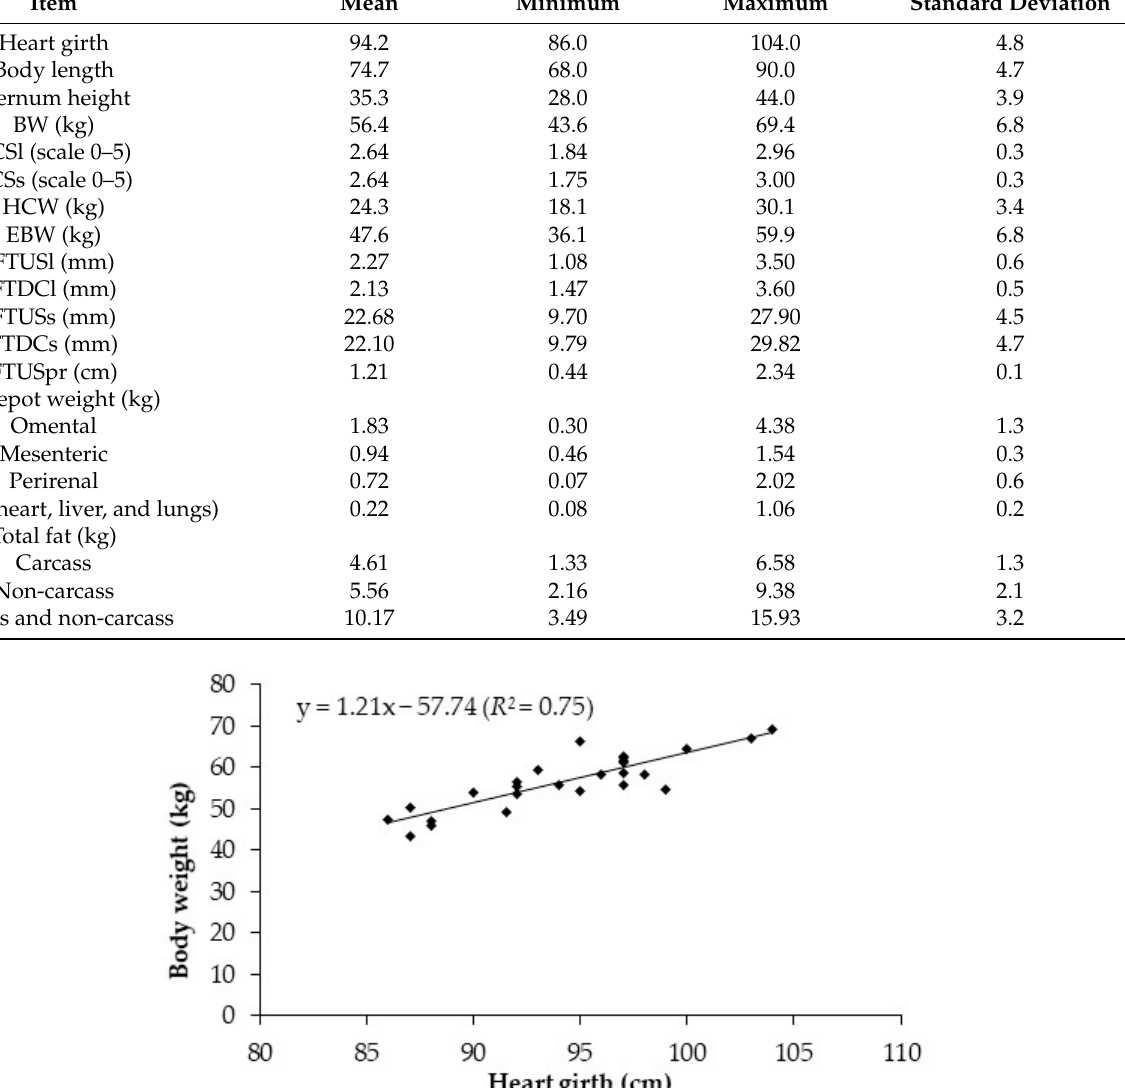
Figure 1. Relationship between heart girth and body weight in lactating Saanen goats.